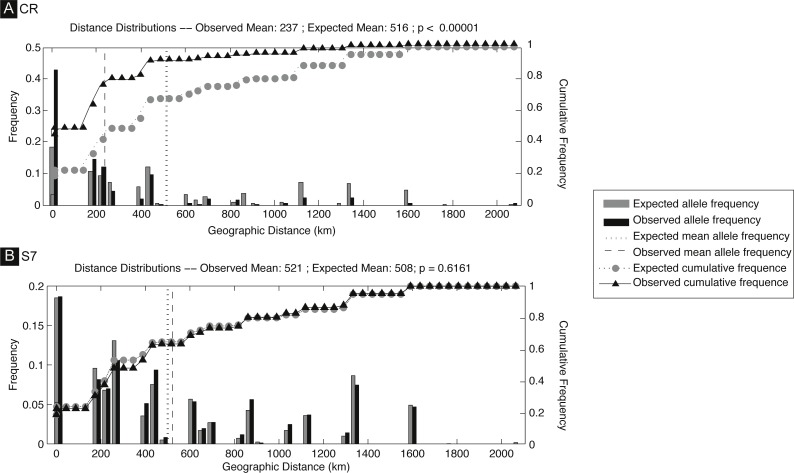
Spatial analysis of shared CR mtDNA distribution of Salaria pavo.Spatial analysis of shared alleles for control region (A) and S7 (B). The geographic distances observed between co-occurring alleles and those expected under panmixia are given in the form of histograms and as cumulative frequency plots. The observed and expected mean distances are indicated with vertical lines. Vertical lines represent the observed and expected mean distances. Triangles and circles are the cumulative frequency of alleles at increasing distance. p-value is the probability that the observed mean is greater than the expected.